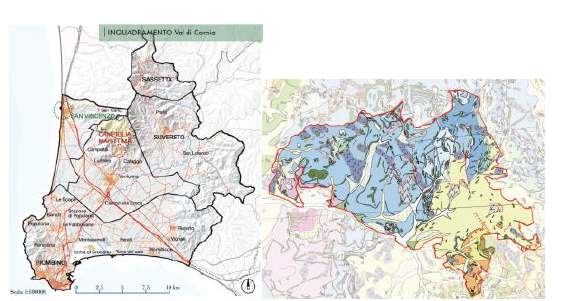
Figure 2. (left) The general framework map of the area, (right) the geological Continuum Map